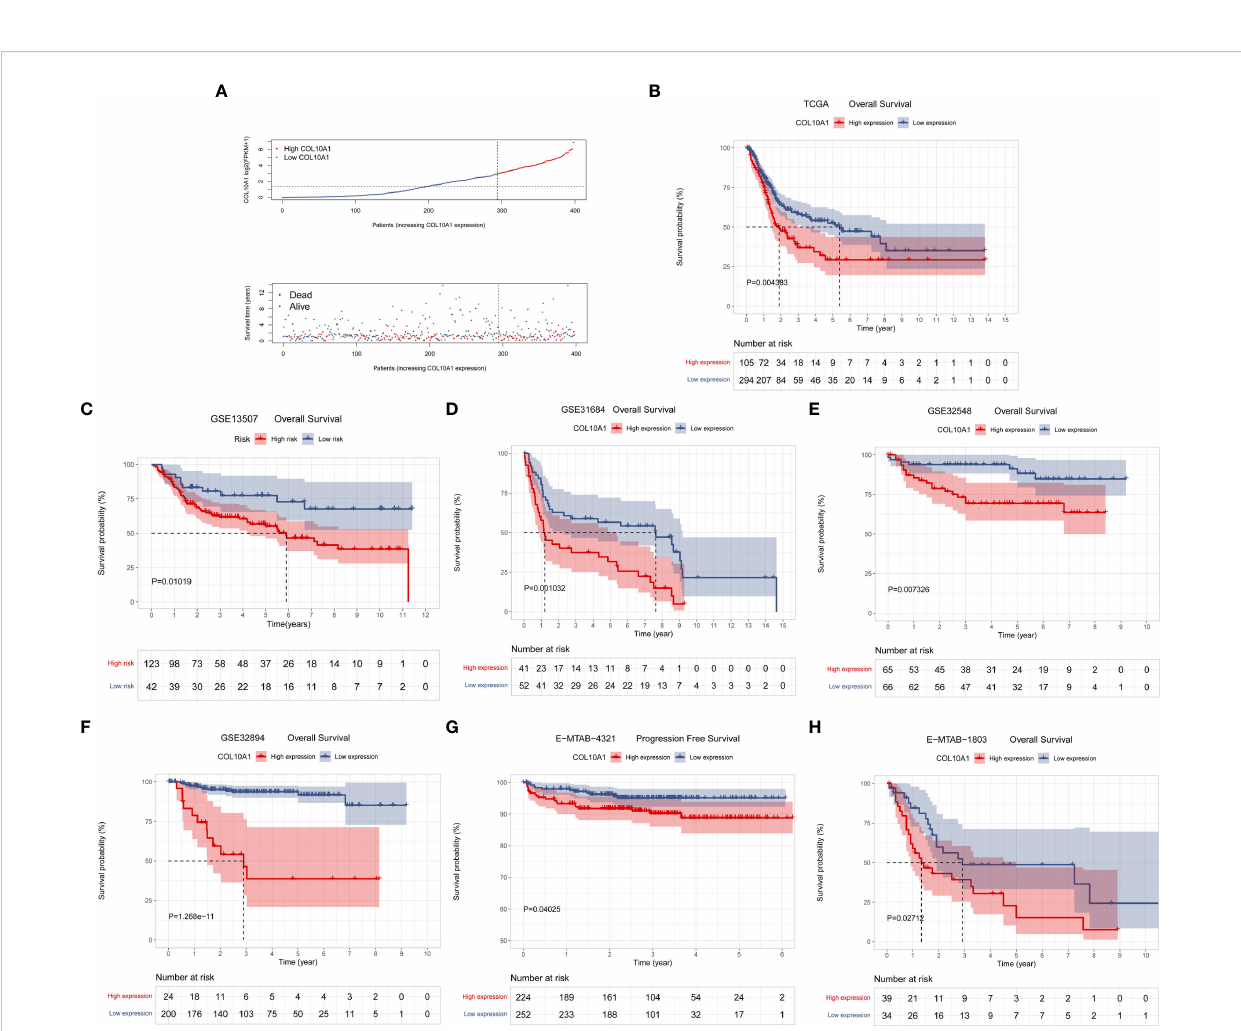
FIGURE 2 The COL10A1 expression level was associated with the prognosis of BLCA patients. (A) The distribution of COL10A1 expression and survival status of BLCA patients in the TCGA cohort. Kaplan – Meier analyses to evaluate the correlation between COL10A1 expression and the overall survival (OS) of BLCA patients in the TCGA (B) , GSE13507 (C) , GSE31684 (D) , GSE32548 (E) , GSE32894 (F) , E-MTAB-1803 (H) cohorts and progression free survival (PFS) in the E-MTAB-4321 (G) cohort indicated that higher COL10A1 expression was correlated to poorer prognosis of BLCA